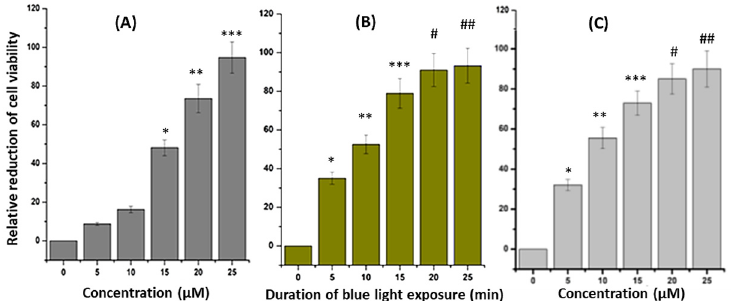
Figure 2. MTT assay showing: ( A ) the effect of increasing doses (0–25 µM) of Curcumin on T98G cell line after 24 h, ( B ) the effect of increasing blue light exposure (0–25 min) in T98G, and ( C ) LN229 cell line pretreated with Curcumin (10 µM). The significant results presenting p values < 0.05 were labeled as *. In ( A ), * denoted control versus 15 µM, ** denoted control versus 20 µM, and *** denoted control versus 25 µM. In ( B ), * denoted control versus 5 min of blue light exposure in 10 µM Curcumin pretreated T98G cells, ** denoted control versus 10 min of blue light exposure in 10 µM Curcumin-pretreated cells, and *** denoted control versus 15 min of blue light exposure in 10 µM Curcumin-pretreated cells. In the case of #, the p value was < 0.005 (# denoted control versus 20 µM Curcumin-pretreated ## denoted control versus 25 µM Curcumin-pretreated LN229 cells).